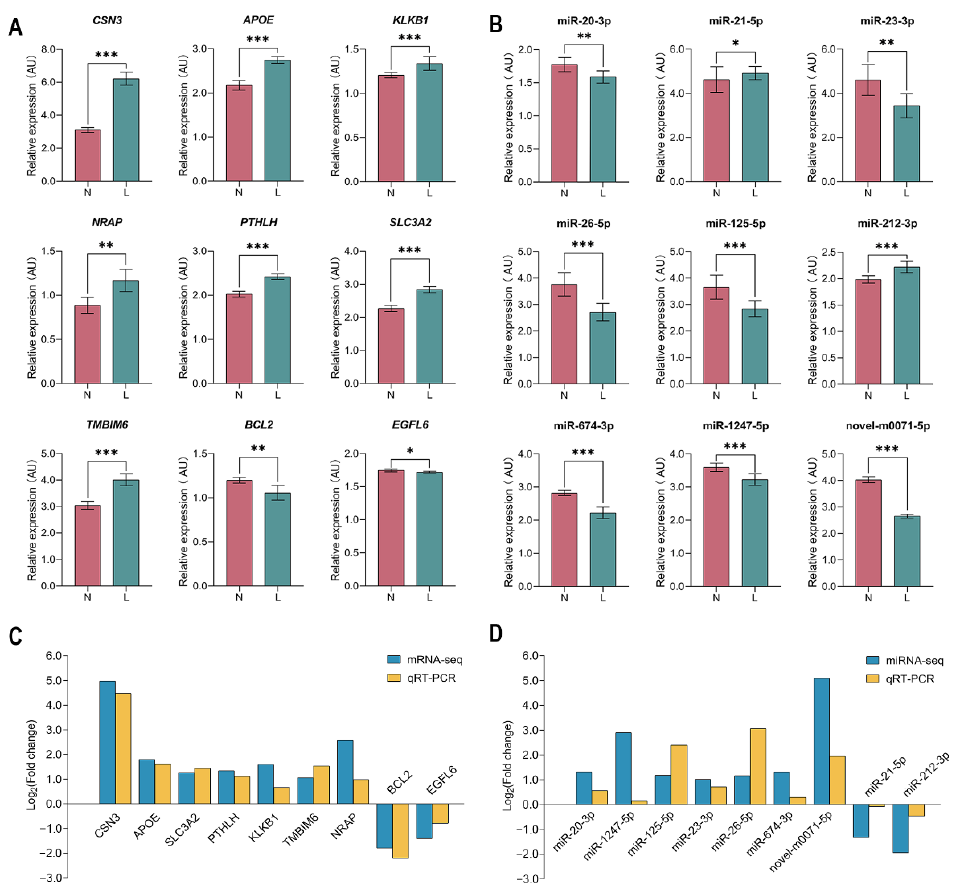
Figure 7. Verification of DE mRNAs and DE miRNAs by qRT-PCR. ( A ) qRT-PCR analysis of nine randomly selected mRNAs. Data represent the means ± SD. ( B ) qRT-PCR analysis of nine randomly selected miRNAs. Data represent the means ± SD. ( C ) Comparison of mRNA expression in terms of Log 2 (fold change) as assessed by mRNA sequencing and qRT-PCR. ( D ) Comparison of miRNA expression in terms of the Log 2 (fold change) as assessed by miRNA sequencing and qRT-PCR. L, lactating mammary glands of jennies; N, nonlactating mammary glands of jennies. * p < 0.05; ** p < 0.01; *** p < 0.001.